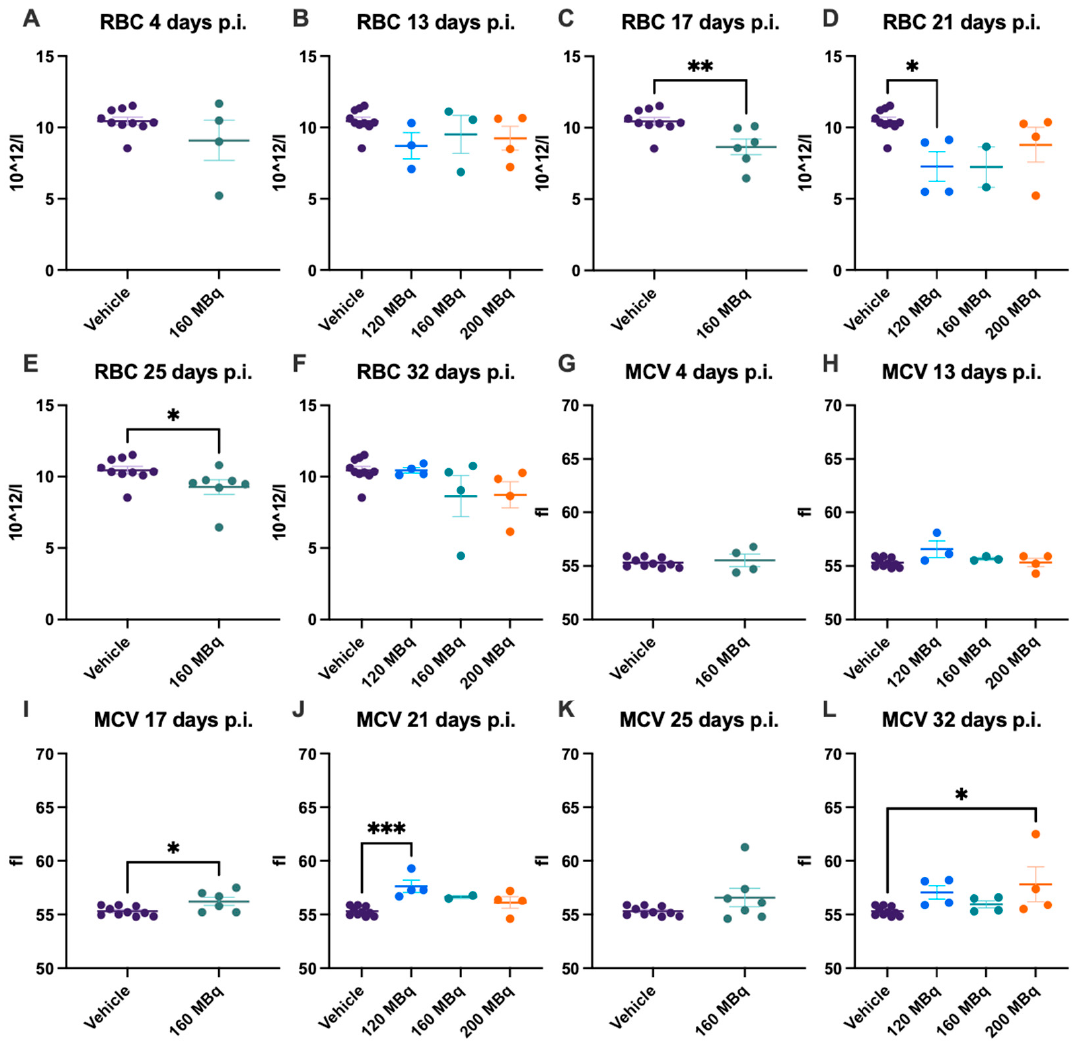
Figure 3. RBC count after 4 ( A ), 13 ( B ), 17 ( C ), 21 ( D ), 25 ( E ), and 32 days ( F ) post injection of 120 MBq ( B , D , F ), 160 MBq ( A – F ), or 200 MBq ( B , D , F ). MCV after 4 ( G ), 13 ( H ), 17 ( I ), 21 ( J ), 25 ( K ), and 32 days ( L ) post injection of 120 MBq ( H , J , L ), 160 MBq ( G – L ), or 200 MBq ( H , J , L ). Values are pre- sented as individual plots with group mean ± SEM. Differences between groups were analyzed us- ing an unpaired t- test ( A , C , E , G , I , K ) or one-way ANOVA with post-hoc Tukey ( B , D , F , H , J , L ). * p < 0.05, ** p < 0.01, *** p < 0.001.